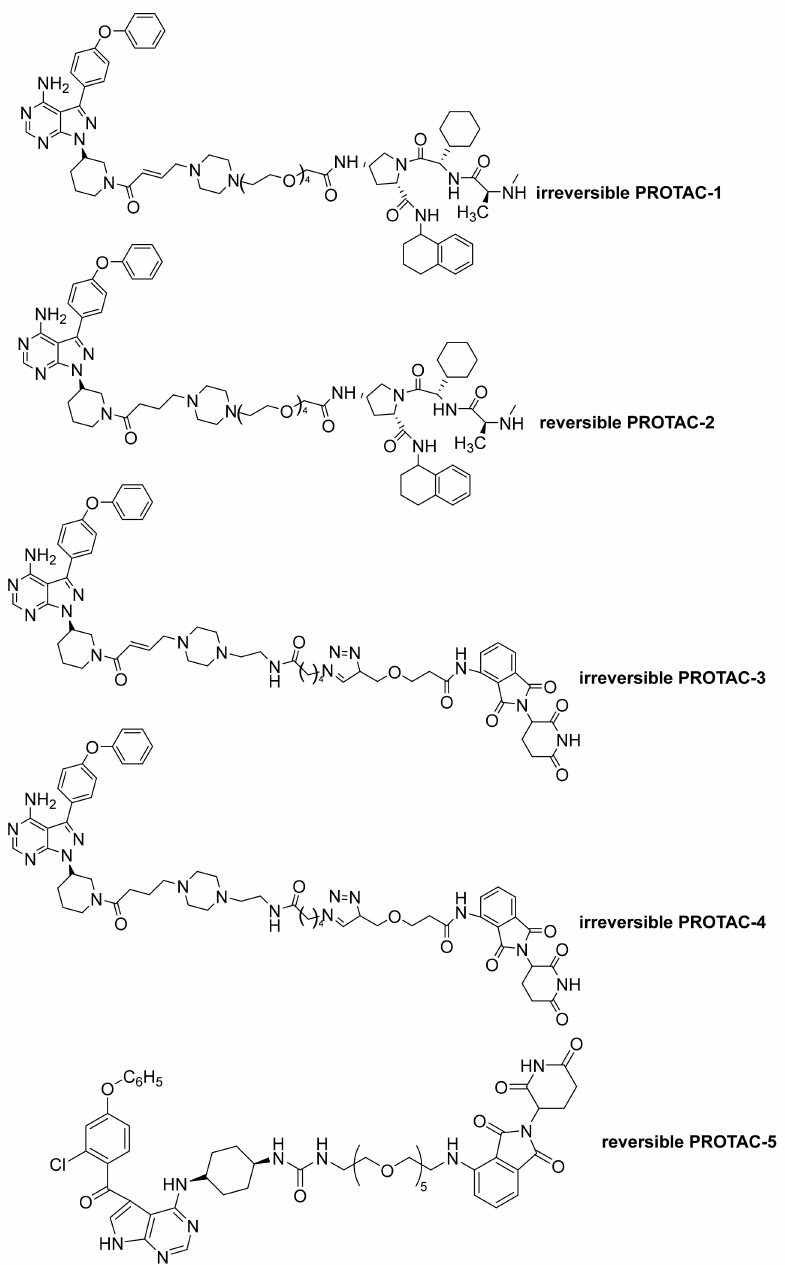
Figure 13. PROTAC